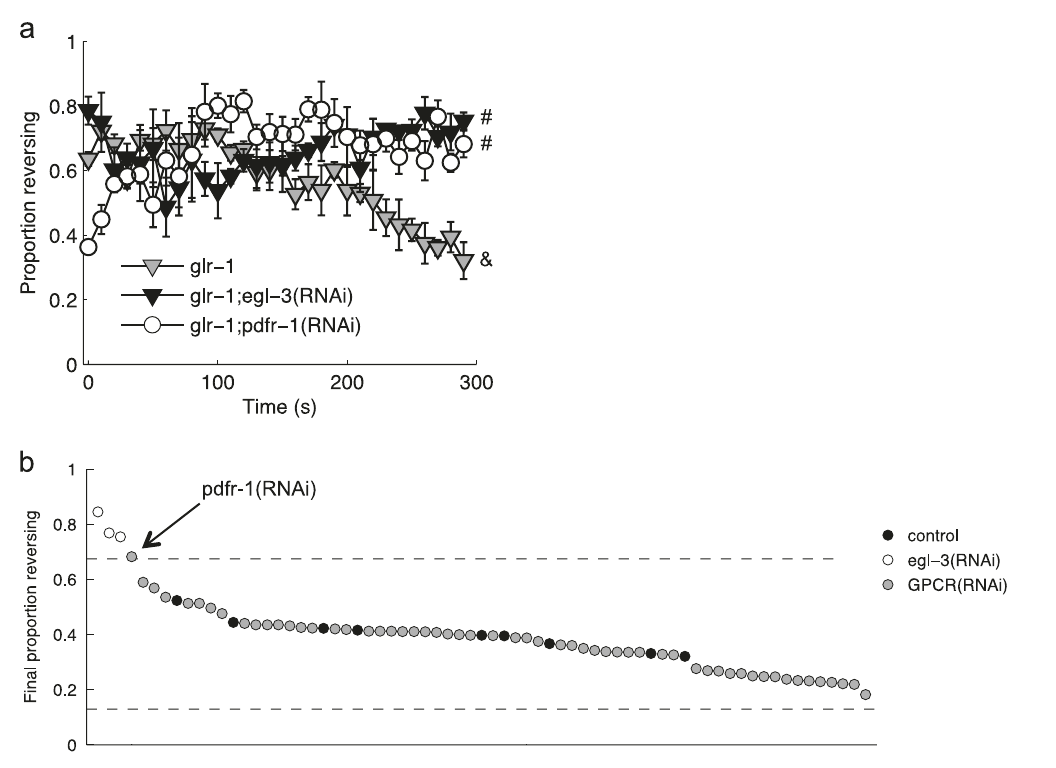
Fig. 2 GPCR RNAi screen. a Proportion of the population reversing to each stimulus for animals fed RNAi clones that increased the probability of a reversal to the fi nal stimulus. Mean ± SEM. ‘ # ’ and ‘ & ’ denote signi fi cantly different groups based on the likelihood of responding to the fi nal stimulus. b Proportion of animals reversing to the fi nal stimulus for populations fed RNAi clones to knockdown egl-3 or one of 57 GPCRs. Knockdown was done in a background sensitized to neuronal RNAi by feeding: glr-1 ; lin-15b ; sid-1 ; unc-11 9p:: sid-1 . Each circle is the mean of three plates, with multiple replicates for the control and egl-3 targeting vector. Dashed lines mark upper and lower critical values (values corresponding to | z -score | > 4.46; P < (0.05/57 = )